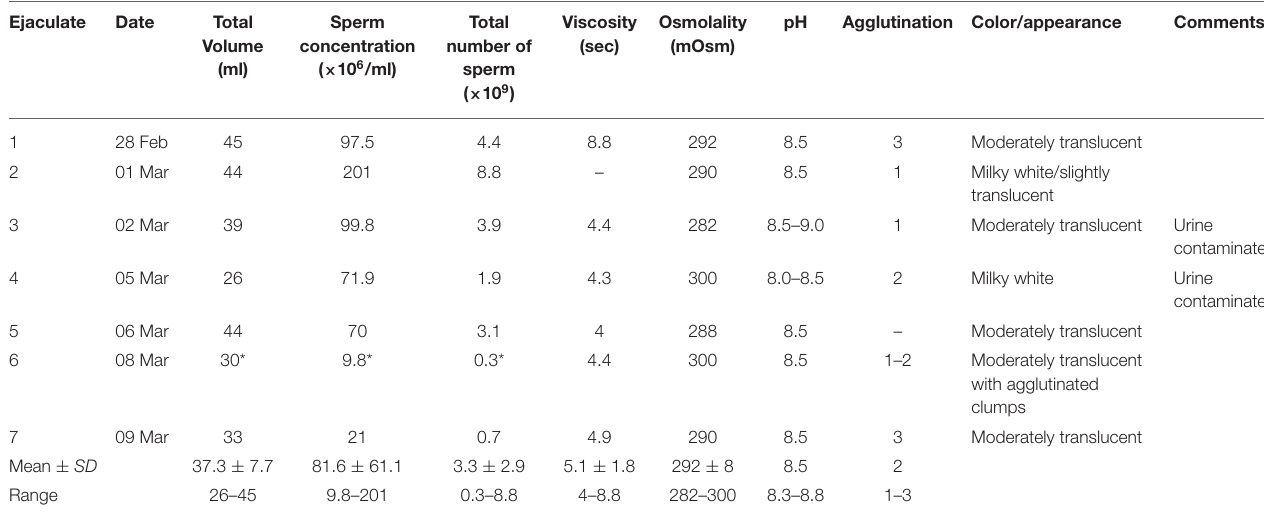
TABLE 1 | Macroscopic and microscopic characteristics of each ejaculate